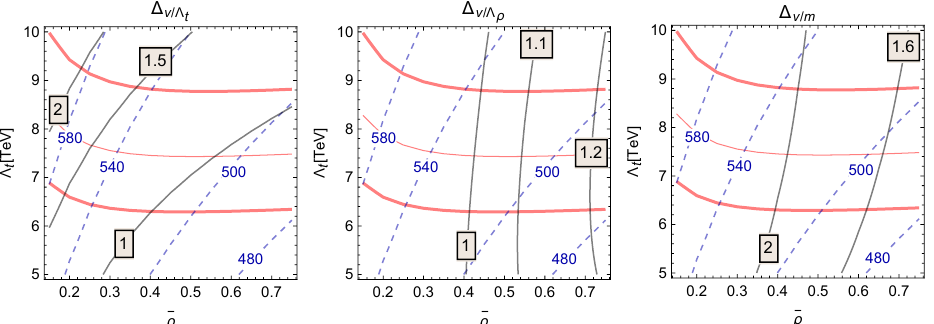
Figure 5 . The total tuning of v with respect to the mass parameters m 2 ; (cid:3) 2 of (cid:22) (cid:26) and (cid:3) t . The red band denotes the Higgs mass window (122 GeV, 128 GeV), while the dashed line indicates the value of the scale f in unit of